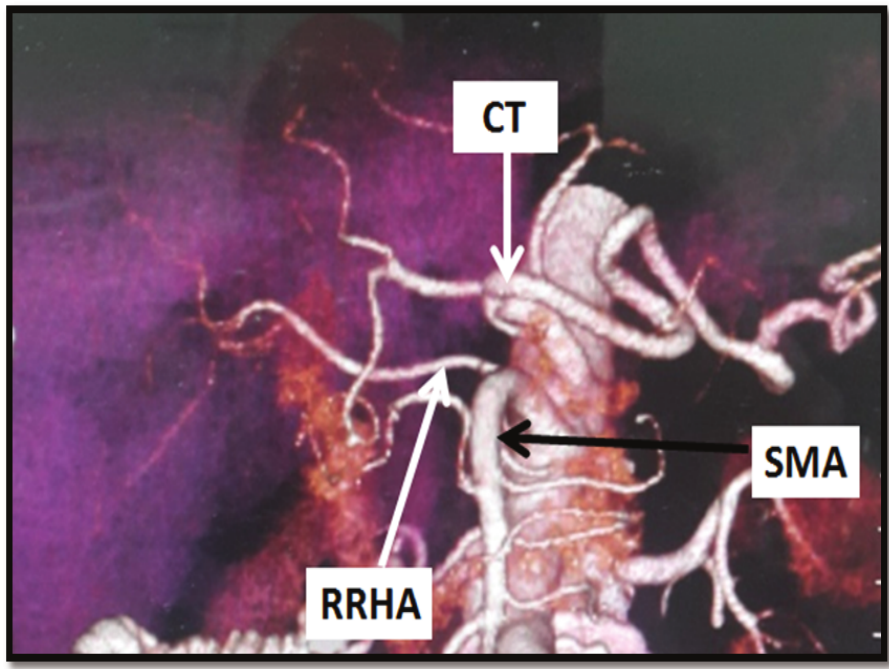
Figure 4 : CT angiography of Toshiba Aquilion 𝑇𝑀 64 slice (Toshiba Medical Systems, Nasu, Japan) showing Michel type III replaced right hepatic artery from superior mesenteric artery + quadrification of the celiac